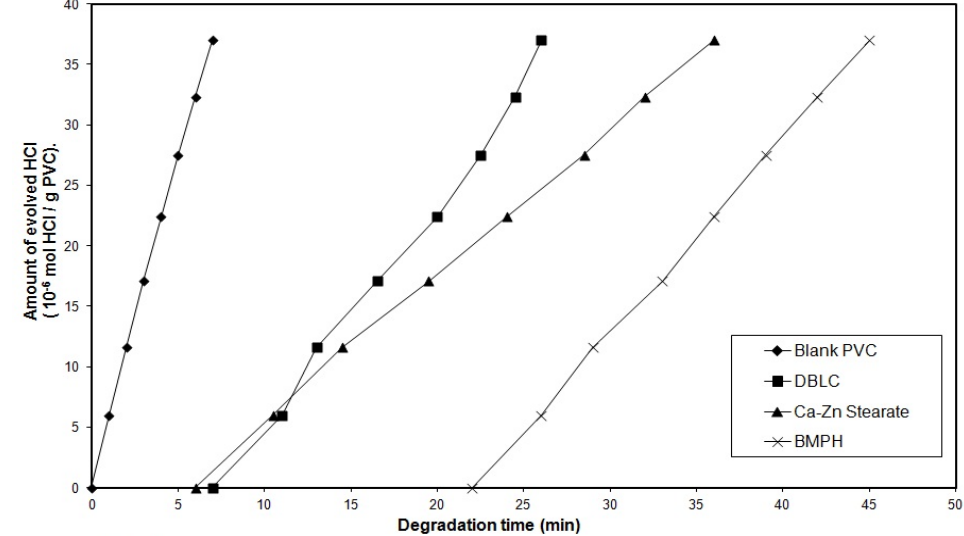
Figure 3. Dehydrochlorination rate of rigid PVC (DBLC, Ca-Zn stearate, BMPH) at